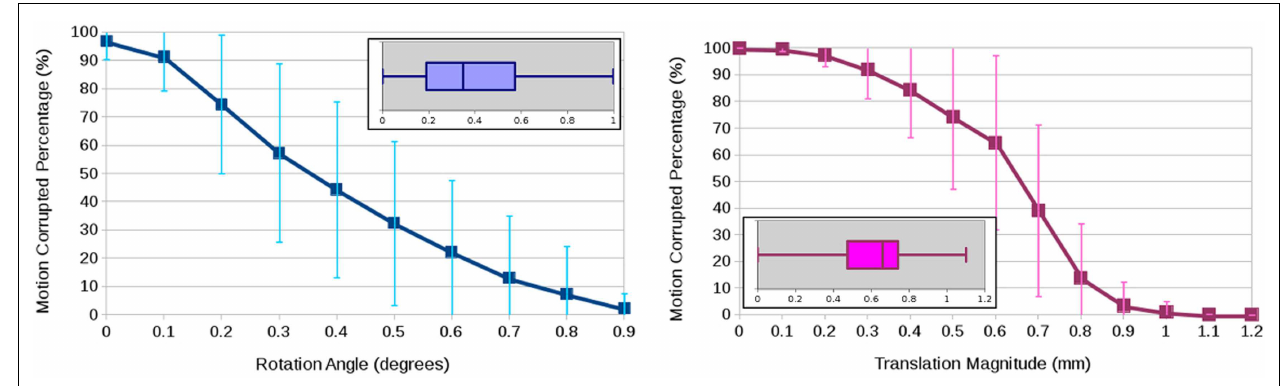
translation magnitude in millimeter (right) for three human phantoms scanned twice at four clinical sites .The boxplots show the overall statistics of estimated motion